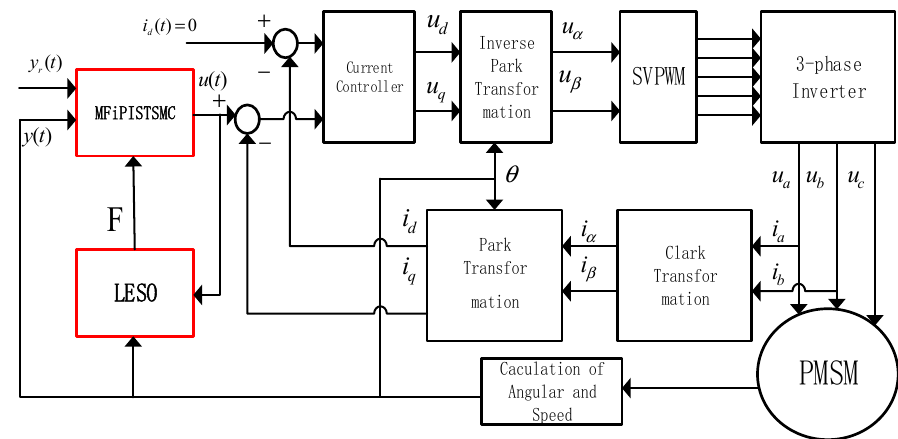
Figure 1. The novel control block diagram using the proposed MFiPISTSMC strategy with 0)( = ti